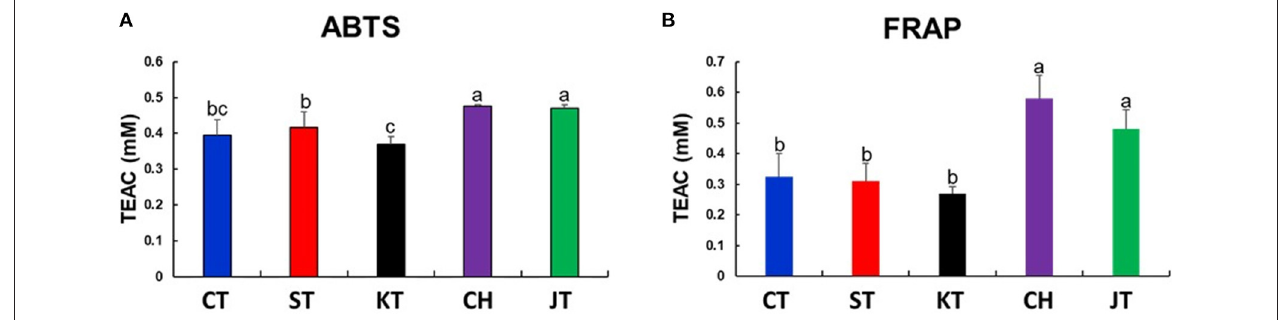
FIGURE 2 | Results of antioxidant activities [2,2 ′ -azinobis (3-ethylbenzothiazoline-6-sulfonic acid) diammonium salt (ABTS) (A) and ferric reducing antioxidant power (FRAP) (B) ] in five types of tomato. Different letters in the bar graph indicate significant difference by ANOVA followed by Duncan’s multiple range test ( p -value < 0.05). TEAC, trolox equivalent antioxidant capacity; CT, chal tomato; ST, tomato; KT, kumato; CH, cherry tomato; JT, jujube-shaped cherry